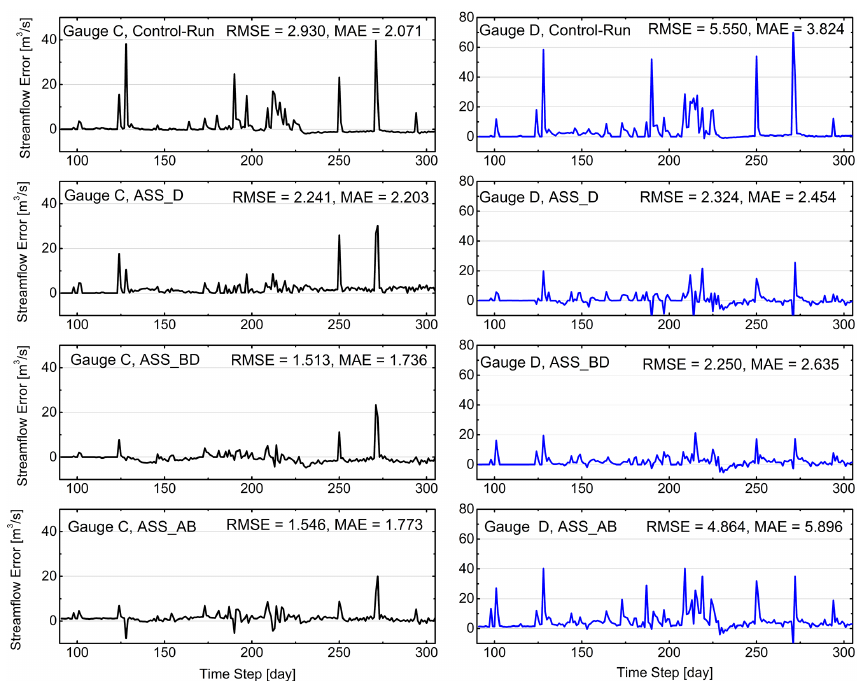
Figure 6. Streamflow predictions using four scenarios of different parameter sets. Only results of Gauges C and D are shown.